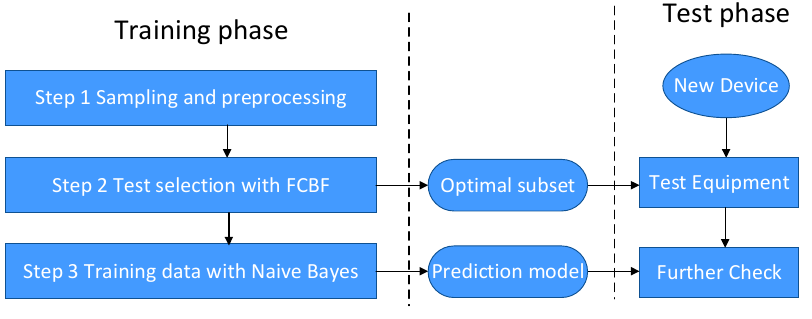
Figure 1. The proposed adaptive test flow.